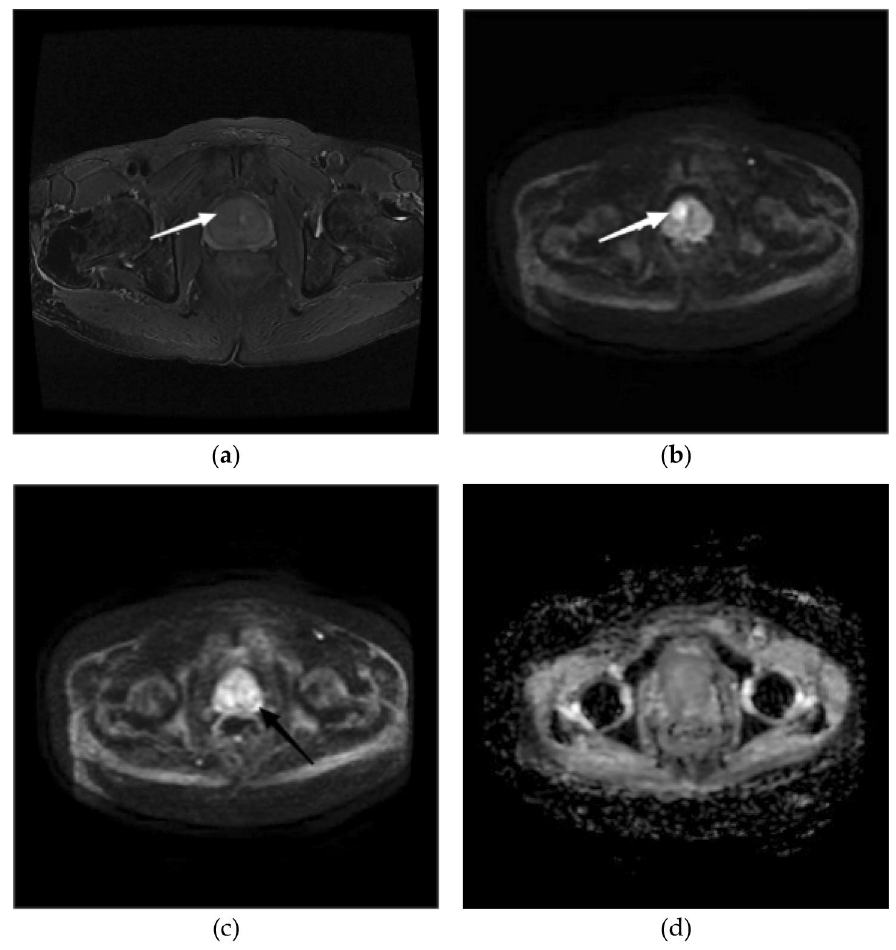
Figure 4. An 80-year-old patient with a PI-RADS v2.1 score of 3 + 3. Transition zone (TZ): ( a ) Axial T2WI shows a heterogeneous signal intensity with obscured margins nodule (white arrow). ( b ) DWI map shows a focal lesion with a markedly hyperintense signal (white arrow) corresponding to the lesion seen in ( a ). T2WI PI-RADS = 3, DWI PI-RADS = 4, PI-RADS assessment category = 4. Peripheral zone (PZ): ( c ) DWI map shows a focal lesion with a markedly hyperintense signal (black arrow) in the right PZ. ( d ) Apparent diffusion coefficient (ADC) map does not show a markedly hypointense signal corresponding to the lesion seen in ( c ). DWI PI-RADS = 3, ADC PI-RADS = 1, PI-RADS assessment category =